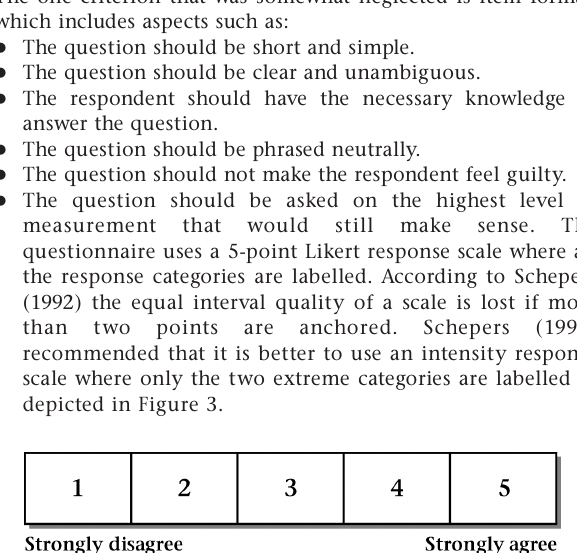
Figure 3: Proposed Intensity Response Scale Schepers (1992, p.14)